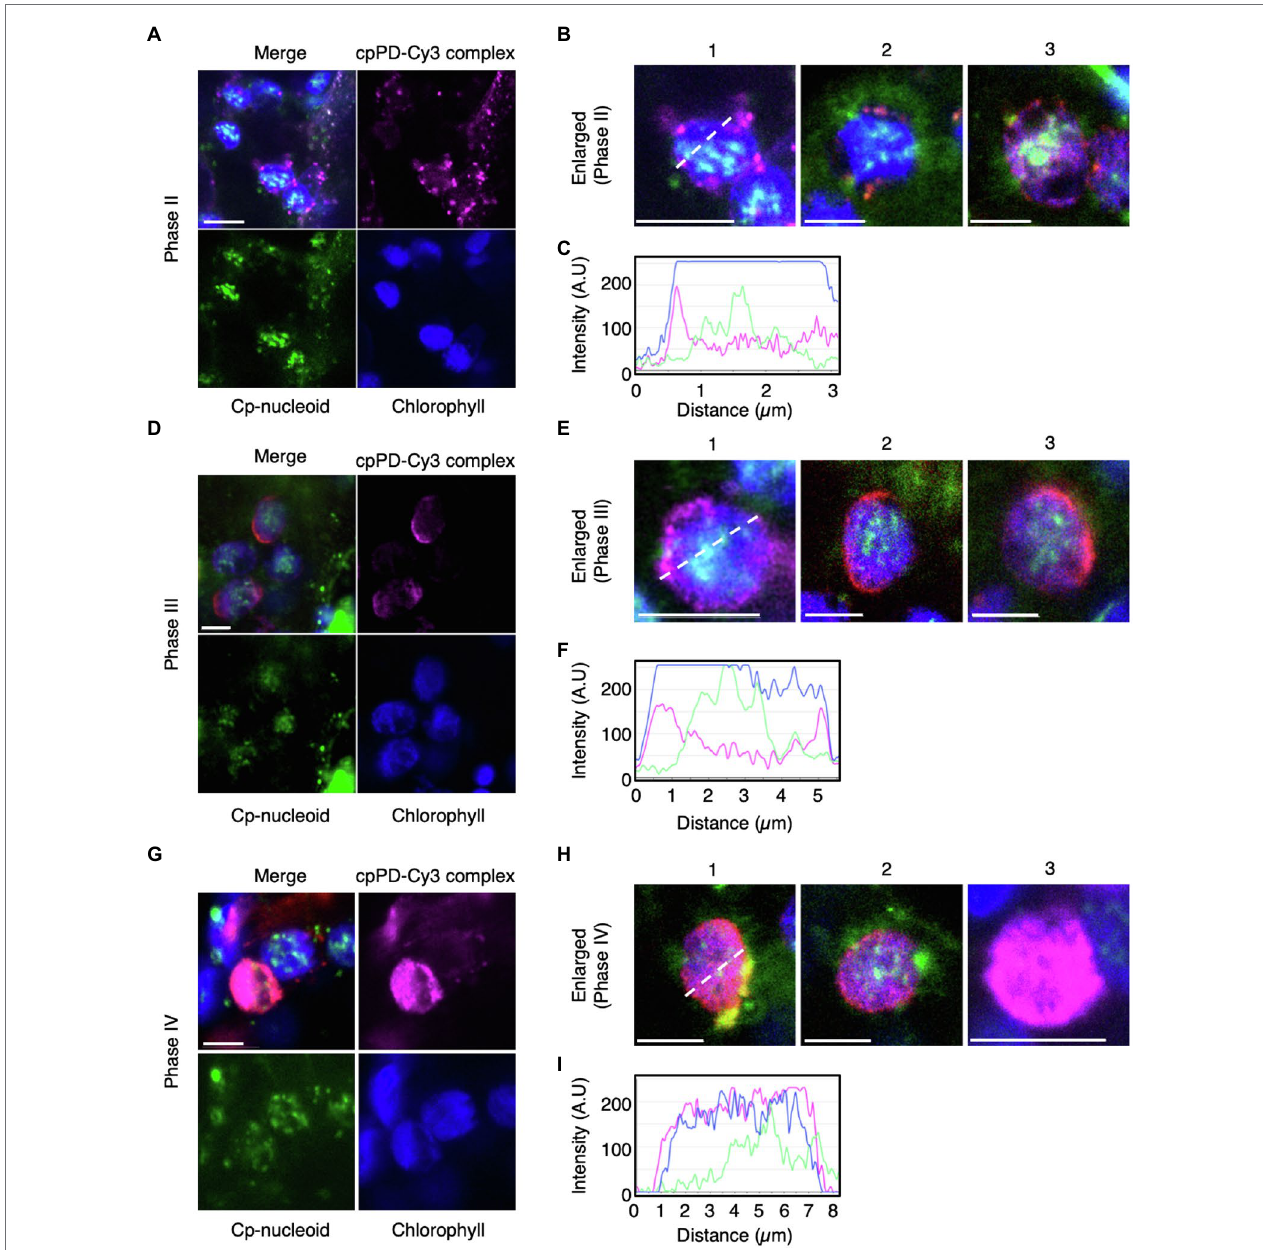
FIGURE 5 | Three different phases of cpPD-Cy3 complexes localization around the chloroplast surface. (A,B,D,E,G,H) KH-AtOEP34–pDNA complexes labeled with Cy3 (cpPD-Cy3; magenta) localize adjacent to the chloroplast surface (blue). The chloroplast genome (cp-nucleoid) was visualized with SYBR Green I (green). Localization of cpPD-Cy3 complexes as dots (A,B) , stacks (D,E) around the chloroplast surface, and throughout the chloroplast stroma (G,H) . (B,E,H) Enlarged images of cpPD-Cy3 complexes from Phases II–IV based on the accumulation patterns of cpPD-Cy3 complexes defined in (A,D,G) in (B,E,H) as follows: the 1-3 means different chloroplasts.. (C,F,I) Fluorescence density profiles along the white dashed line for cpPD-Cy3 complexes at Phase I–III. Bars = 5 μ